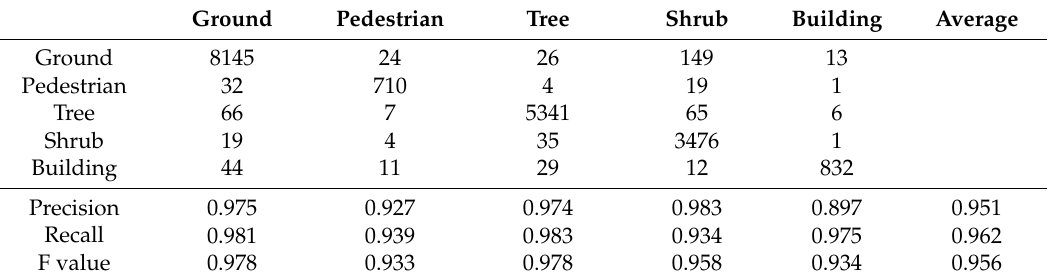
Table 3. Evaluation results of five objects segmentation in Scene B.